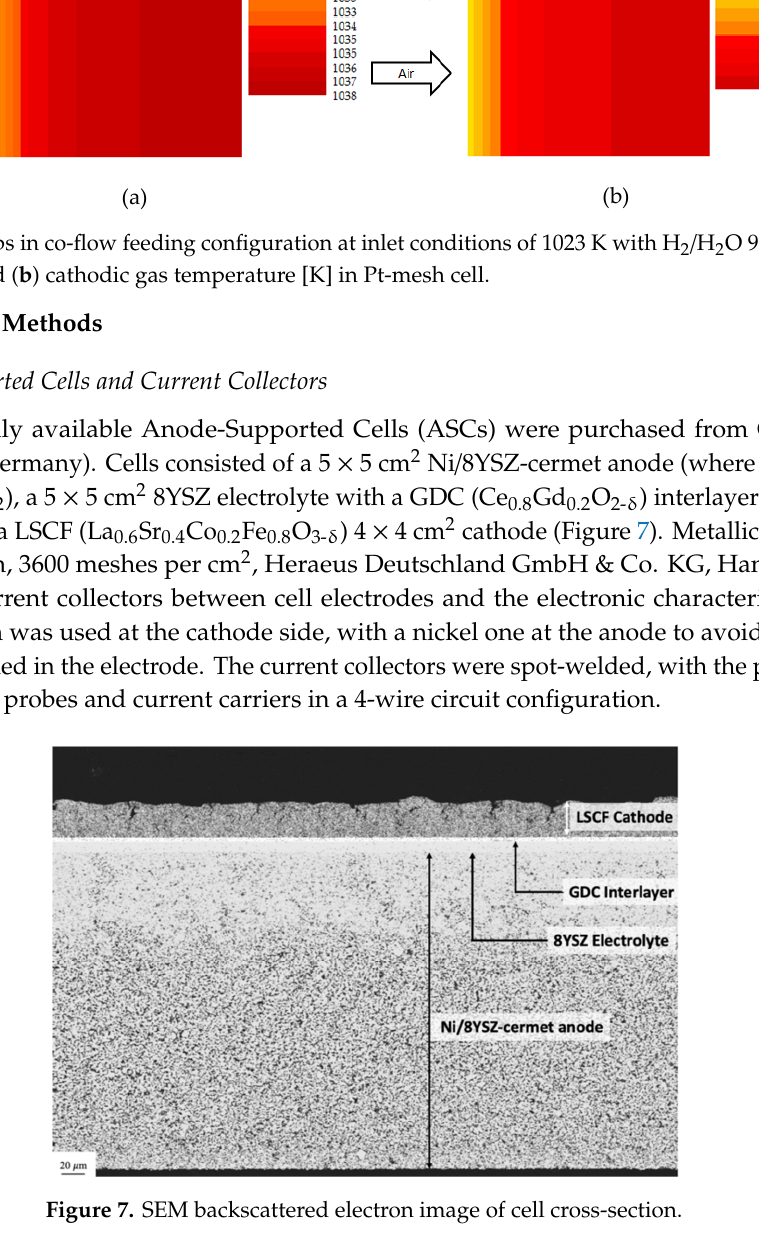
Figure 5. Maps in co-flow feeding configuration at inlet conditions of 1023 K with H 2 / H 2 O 97 / 3 and air: